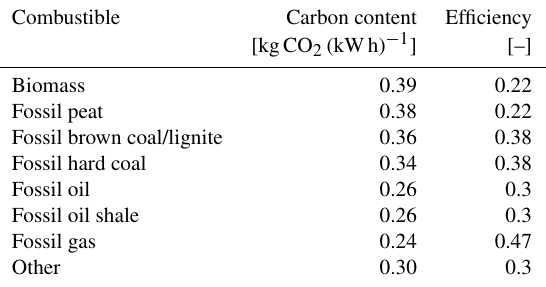
Table 3. Constants for electricity production from different fuels. Carbon contents are taken from Watter (2015), efficiencies from Hussy et al. (2014) and European Environment Agency